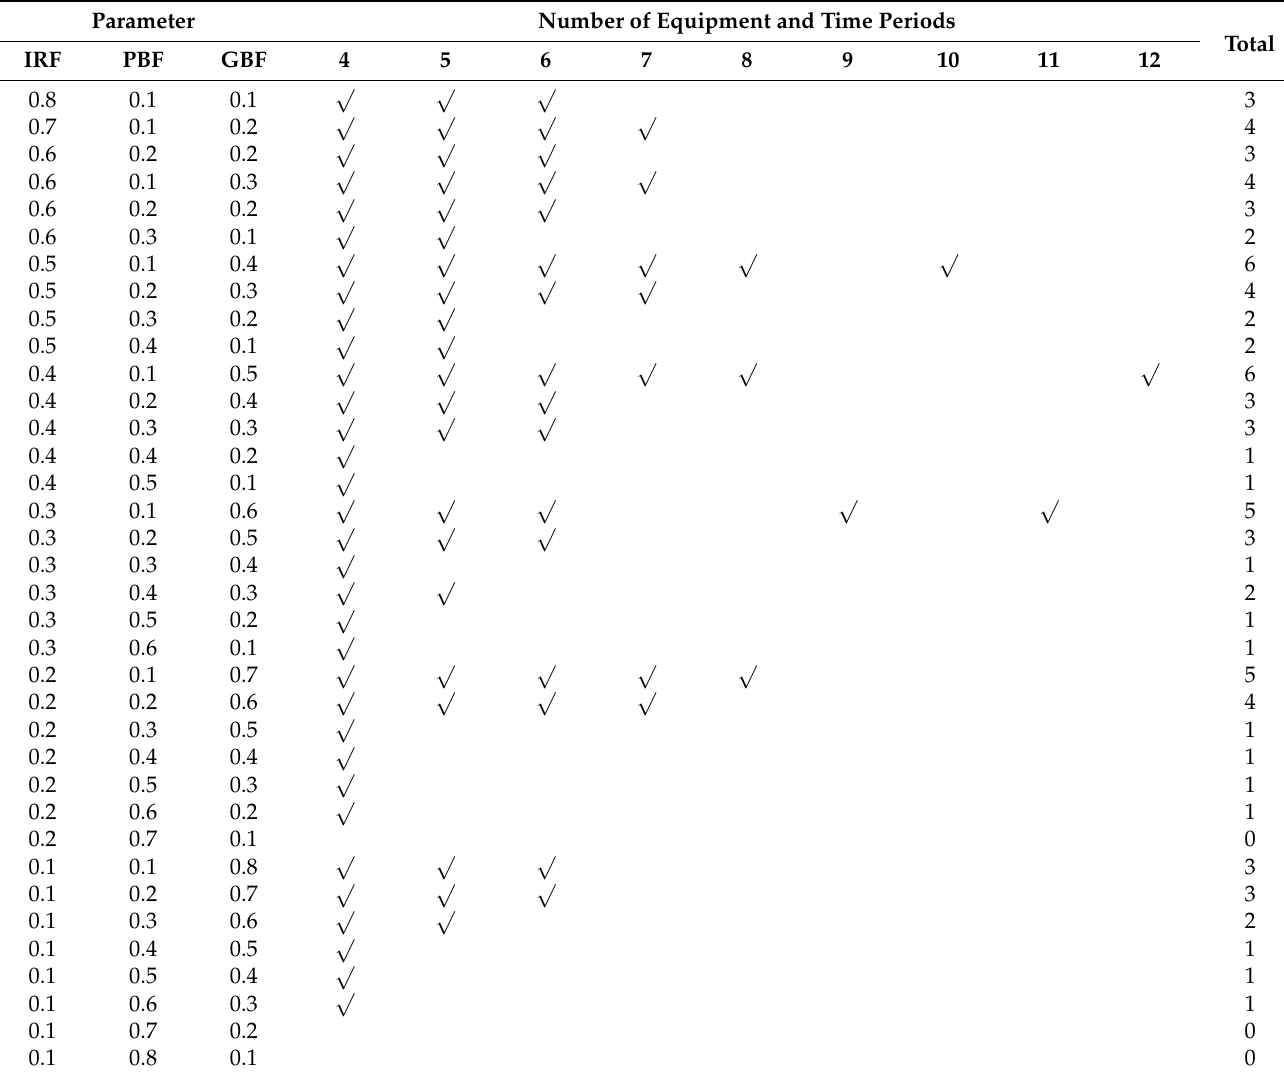
Table 4. Comparison of times required to obtain the best